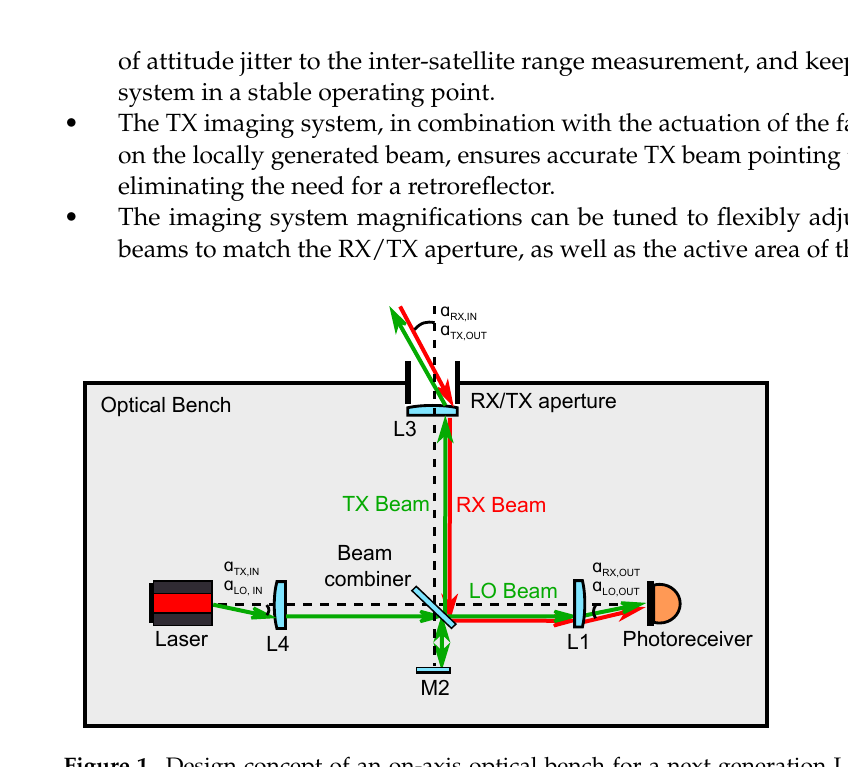
Figure 1. Design concept of an on-axis optical bench for a next generation LRI. The receive and transmit beams (RX and TX, respectively) propagate into and out of the optical bench through the same aperture, where their paths